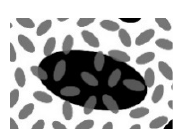
Figure 7. Artificial texture of randomly oriented ellipses in different scale